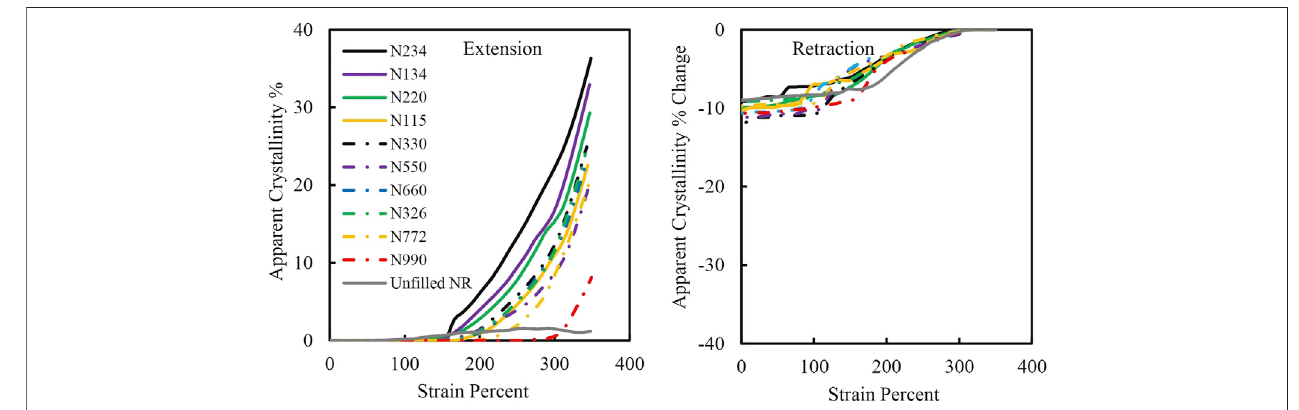
FIGURE 10 | Apparent crystallinity percent of carbon black reinforced and unreinforced natural rubber extended and retracted at 350% strain during cycle 1.